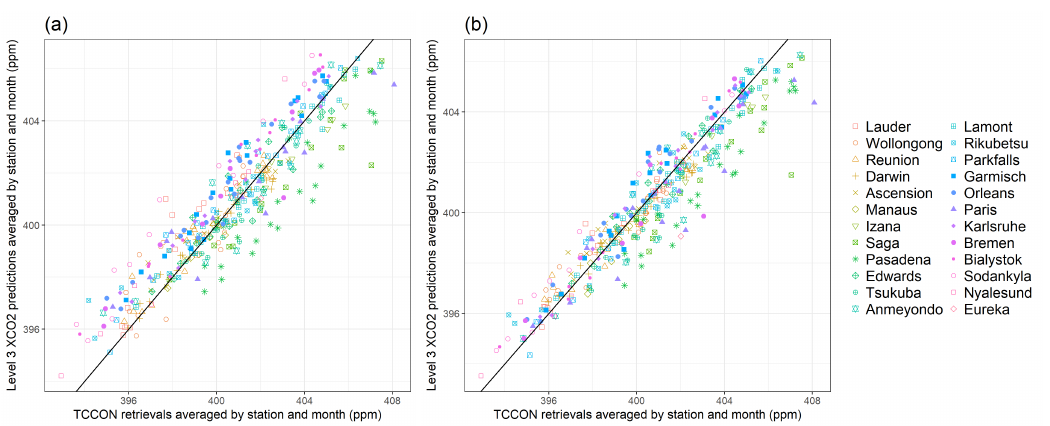
Figure 10. Scatter plots of monthly averages of the Total Carbon Column Observing Network (TCCON) measurements vs. the fixed rank kriging (FRK) predictions, for 24 TCCON stations between October 2014 and February 2017. The line with unit slope constrained to pass through the origin is also shown (black solid line). ( a ) Comparison of TCCON data with the FRK Version 7r product; ( b ) comparison of TCCON data with the FRK Version 8r